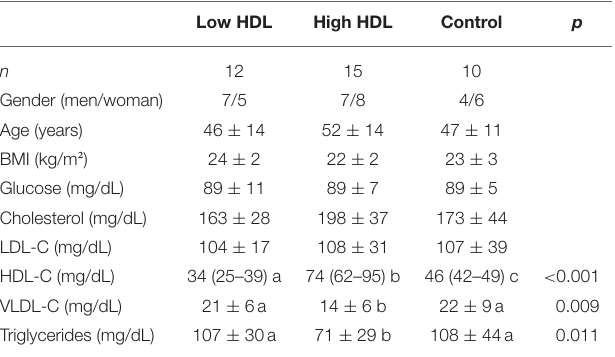
TABLE 1 | Anthropometric data and plasma concentrations of glucose, lipids and